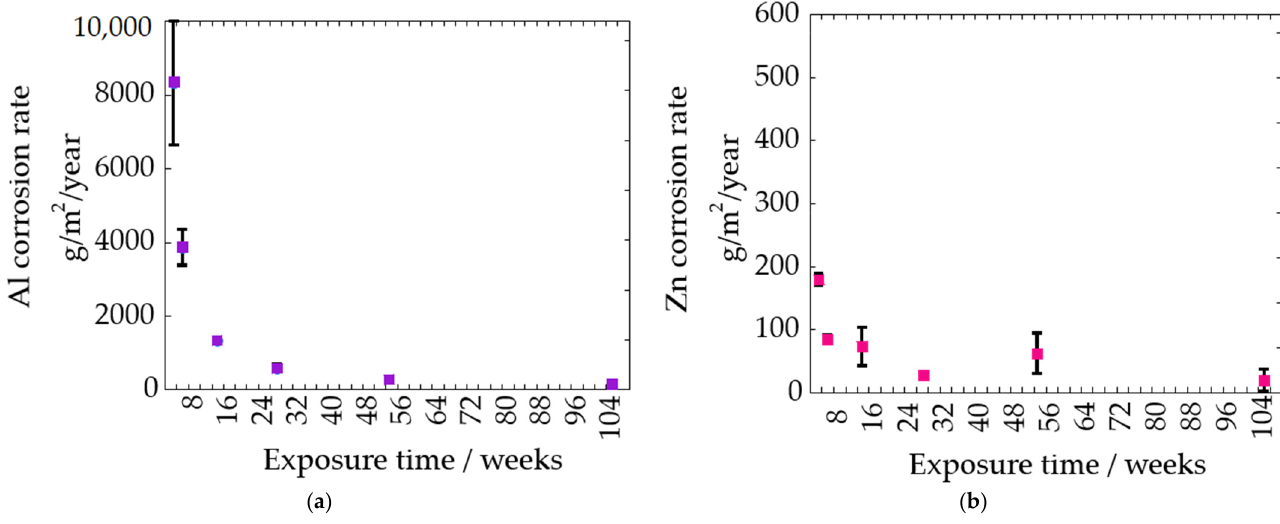
Figure 9. Corrosion rates of Al ( a ) and Zn ( b ) exposed in artificial ground water (AGW) at anaerobic conditions for 2, 4, 12, 24, 52 and 104 weeks.